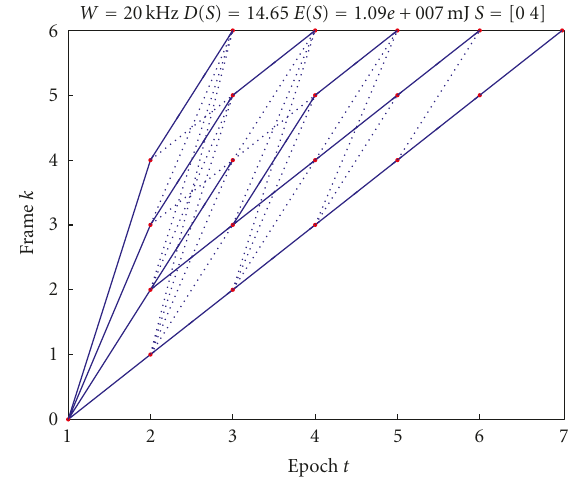
Figure 3: An example of DP trellis for the max distortion min- imization problem.